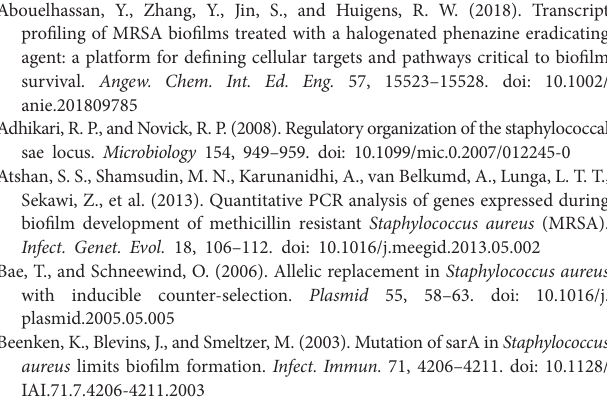
SUPPLEMENTARY FIGURE 1 | Newman ∆fur phenotypic changes. (A) , SDS- PAGE gel of cell wall proteins normally regulated by Fur. Growth in presence of iron is denoted by +Fe and in the absence of iron by –Fe. Lack of Fur is shown by similar cell wall protein composition in +Fe/–Fe. L is Protein ladder (High Range Rainbow Marker). Ct plots obtained for fur and gyrB RT-qPCRs in Newman ∆fur (B) and Newman WT (C) . Absence of fur RNA is shown by high Ct values, which represents unspecific amplification. SUPPLEMENTARY FIGURE 2 | | Newman biofilm viability assayed by resazurin. A Staphylococcus aureus culture grown in RPMI overnight resuspended in fresh medium was diluted to a final concentration of 1 x 10 7 CFU ml -1 in 200 μl of desired medium (RPMI or RPMI supplemented with 2 and 40 µM of FeCl 3 or 0.5 and 10 µM hemoglobin) in a sterile 96-well microtitre plate. The microplate was incubated at 37 ° C and 200 r.p.m for desired time. Spent medium was removed and biofilms were washed twice with PBS. Biofilm viability was assessed by resazurin. SUPPLEMENTARY FIGURE 3 | | ldh1 expression in Newman biofilms. Data is plotted as mean of three biological replicates each including technical triplicates. SUPPLEMENTARY FIGURE 4 | (A) Agr typing in EC12 and BC03 clinical strains. PCR amplification of specific Agr types. 1, 1 kb DNA ladder (Zymo